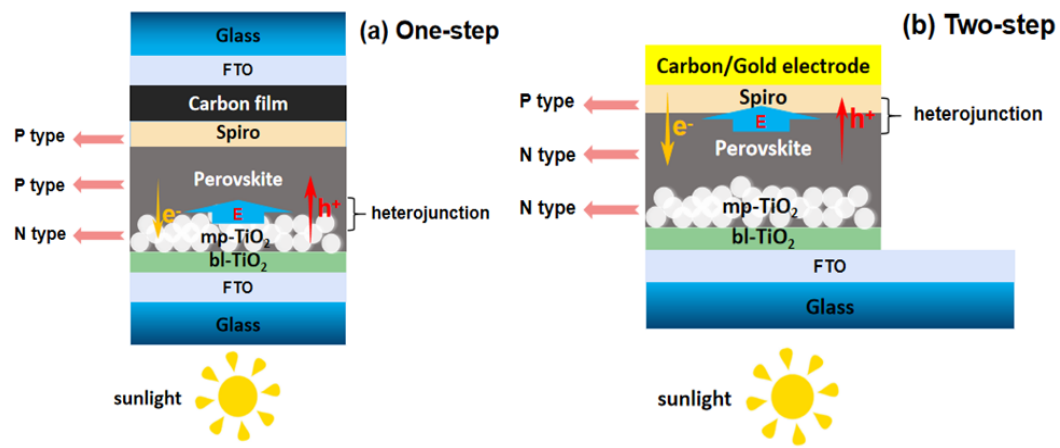
Figure 1. The structure of the device prepared by the one-step method ( a ) and two-step method ( b ) from top to bottom are fluorine-doped SnO 2 FTO (C / Au) / Spiro-OMeTAD / CH 3 NH 3 PbI 3 / mp-TiO 2 / bl-TiO 2 / FTO. The figure includes the direction of the built-in electric field, the direction of carrier migration and the majority carrier type of perovskite films.